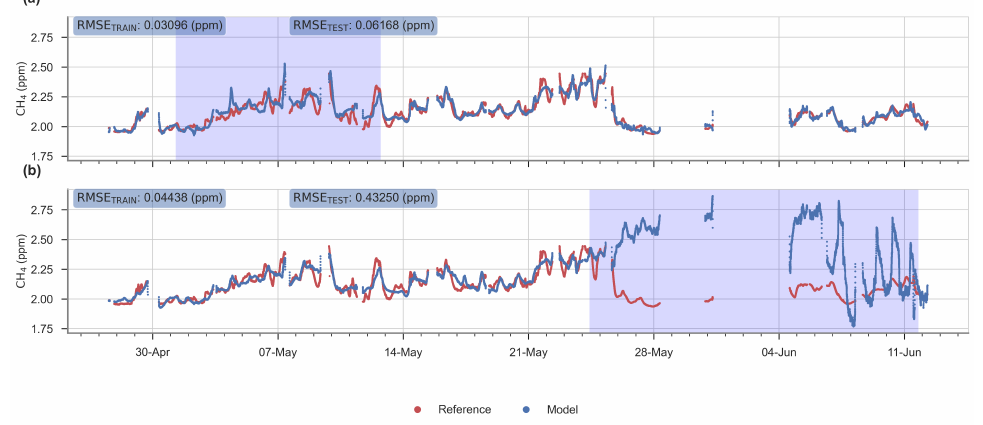
Figure 8. Time series showing a good ( a ) and a bad ( b ) performance of the MLP model for the test period 7 and 50 respectively. In red, time series of the reference instrument, and in blue the reconstructed signal given by the MLP model. White background: observations used for the training stage. Blue background: observations used for the test